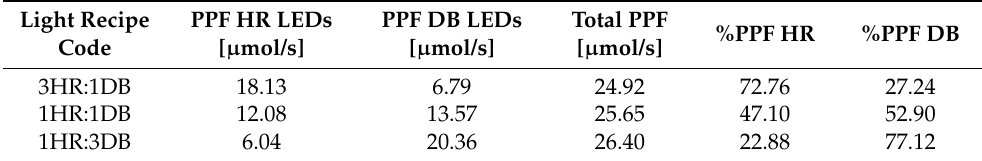
Table 3. Photosynthetic photon flux (PPF)